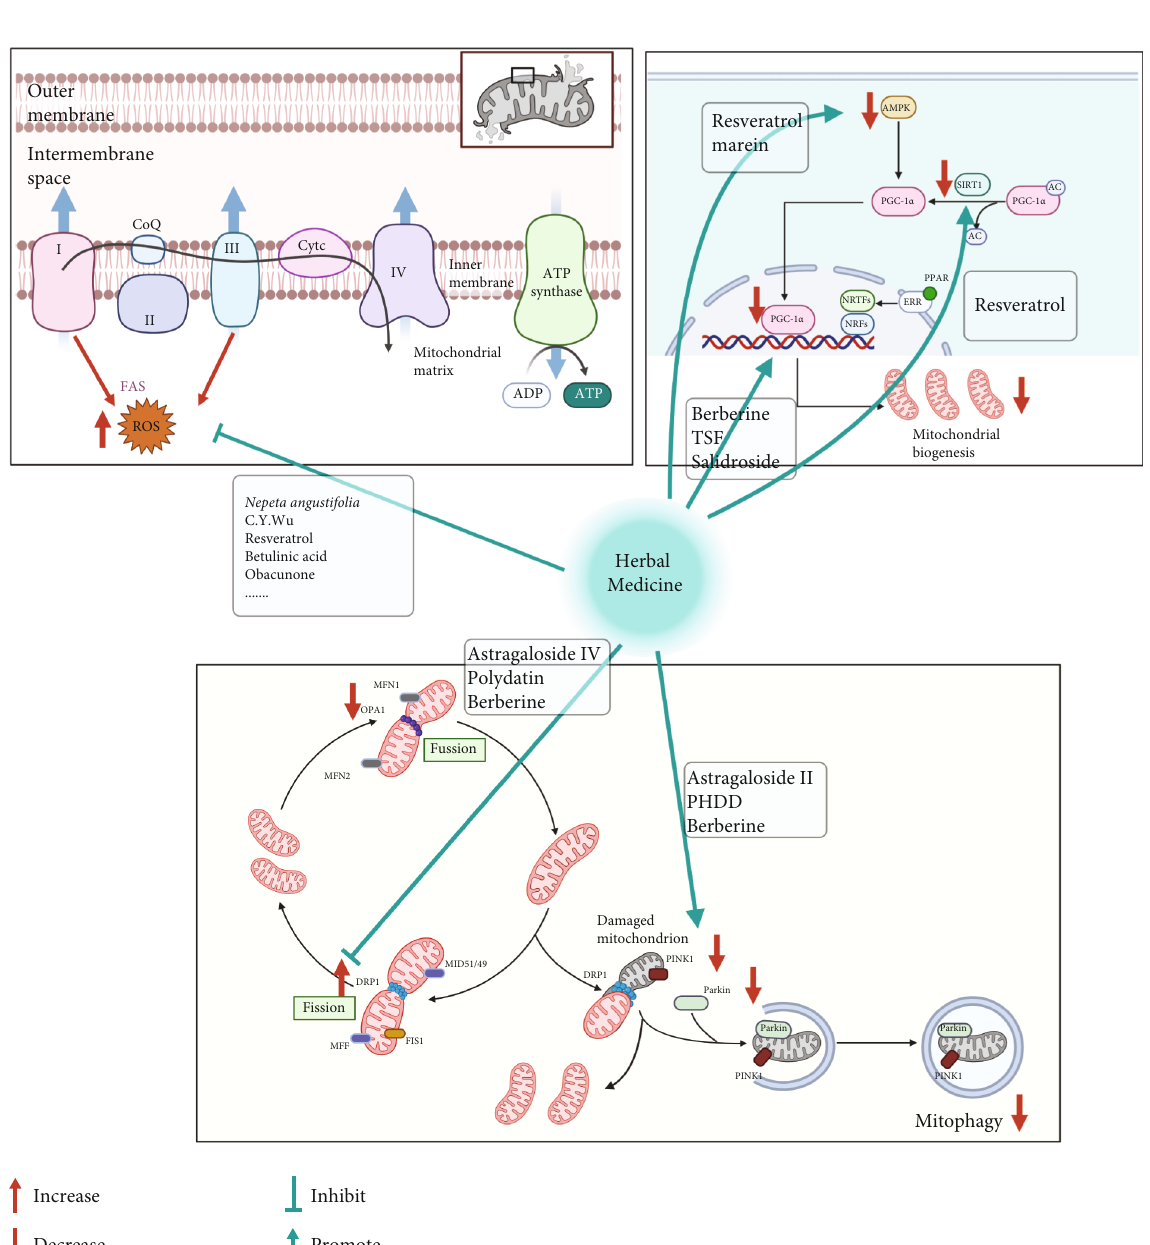
Figure 2: Therapeutic target of herbal medicine on mitochondrial dysfunction in DN. Herbal medicine plays a protective role in inhibiting DRP1-mediated mitochondrial dynamics to improve mitochondrial dysfunction in DN. In addition, herbal medicine enhances mitochondrial biogenesis by inducing the expression of PGC-1 α and its upstream regulators (AMPK and SIRT1) and drives PINK1/ Parkin-mediated mitophagy. In addition, the renoprotective e ff ects of herbal medicine are associated with antioxidative